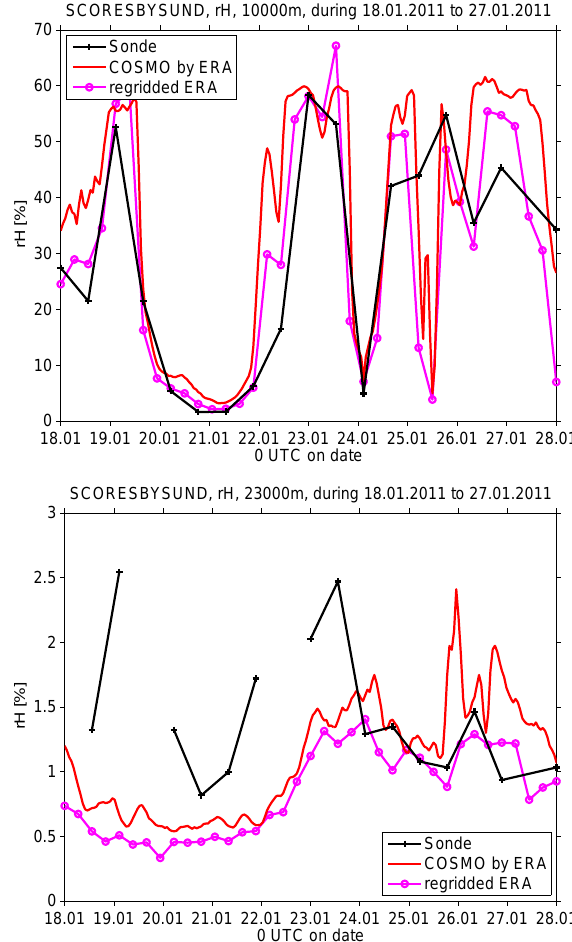
Figure 16. Time series of relative humidity at 10 (top) and 23km (bottom) heights above Scoresbysund for the model, the forcing ERA-Interim reanalysis and the measurement data at the end of Jan- uary